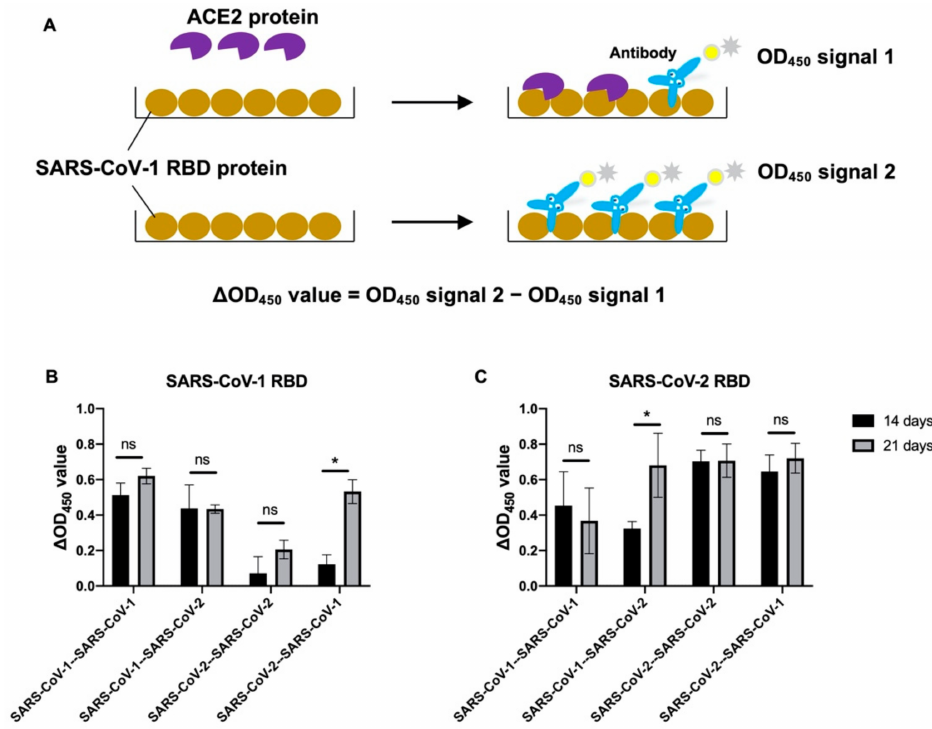
Figure 3. Competition of ACE2 for binding of antibodies in mouse plasma from homologous or heterologous immunization of SARS-CoV-1 and SARS-CoV-2 ( A ) ACE2 competition schematic. SARS- CoV-1 or SARS-CoV-2 RBD protein was captured on the plate. ACE2 protein was premixed with RBD on the plate to test as competitor to block antibody binding to the RBD. The OD 450 value is determined from an anti-human-HRP colorimetric readout. Plasma samples were collected on day 14 or 21 after two rounds of immunization. ( B ) SARS-CoV-1 RBD or ( C ) SARS-CoV-2 RBD protein was used as antigen for ELISA. The ∆ OD 450 values were calculated from the difference between the results of the same plasma with and without hACE2 protein as a blocking agent. Each condition is represented by the mean of the results obtained from at least three mice. p -values were calculated using a two-tailed t -test (* p < 0.05, ns (not